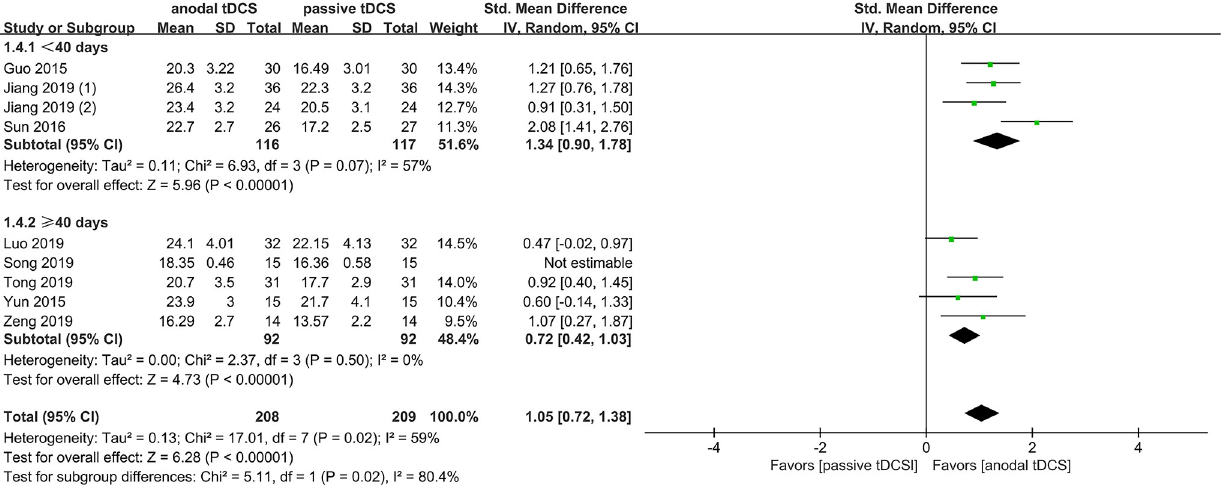
Fig 5. Subgroup analysis based on stroke